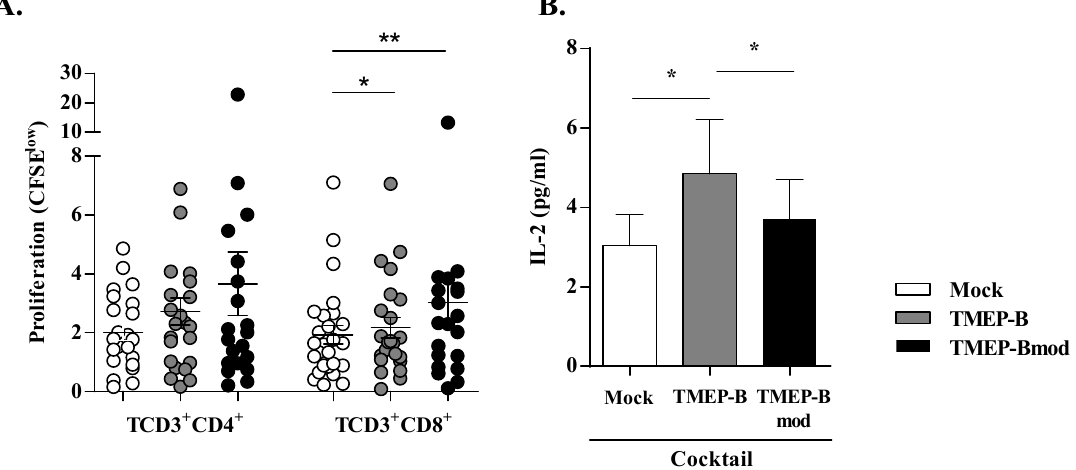
Figure 3. Analysis of HIV-specific T-cell proliferation in co-cultures using DCs electroporated with mRNA TMEP-B or TMEP-Bmod. T-cell proliferation after 6 days of co-culture (DC:T-cells) using DCs from HIV infected patients and electroporated with TMEP-B or TMEP-Bmod. ( A ) Evaluation of HIV-specific T-cell proliferation (CD3+ CD4+ and CD3+ CD8+) using DCs transfected with 10 µ g of TMEP-B or TMEP-Bmod ( n = 26). ( B ) Analysis of IL2 secretion in the supernatant 48 h after co-culture (DC:T-cells) using DCs electroporated with TMEP-B or TMEP-Bmod ( n = 8). The cytokine maturation cocktail was added to all co-cultures. Percentages ± SD are represented. Analysis was by the Wilcoxon signed rank test (* p < 0.05; ** p < 0.01; *** p < 0.001).